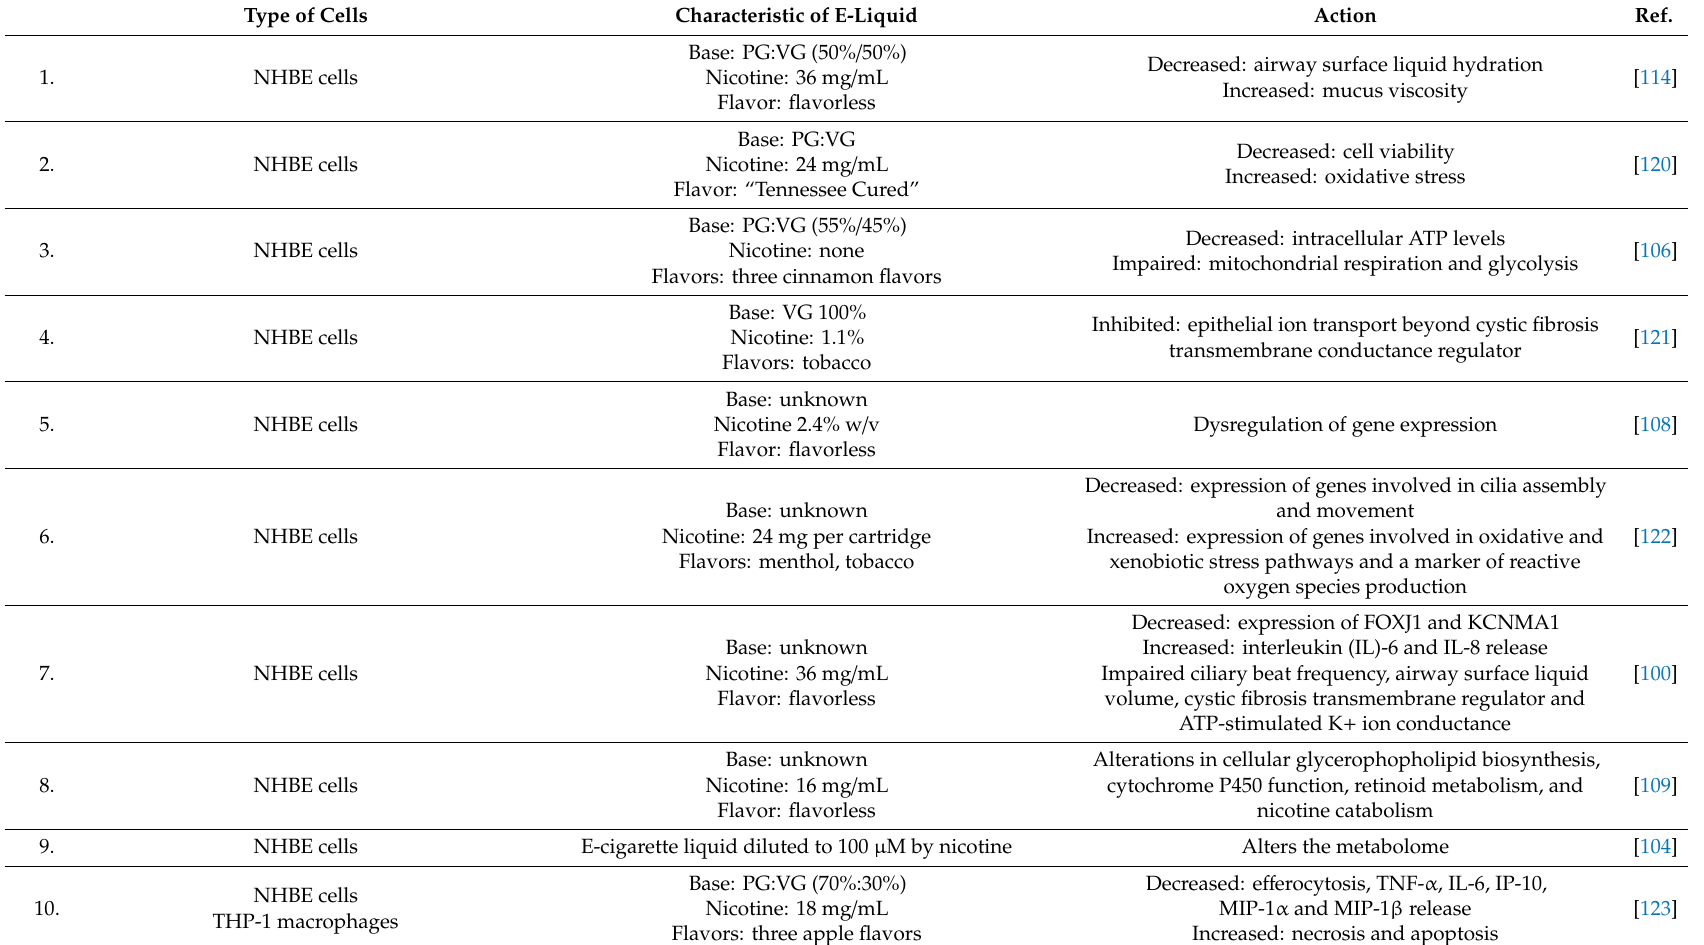
Table 1. The impact of e-cigarette liquid exposure to various cell models (in vitro